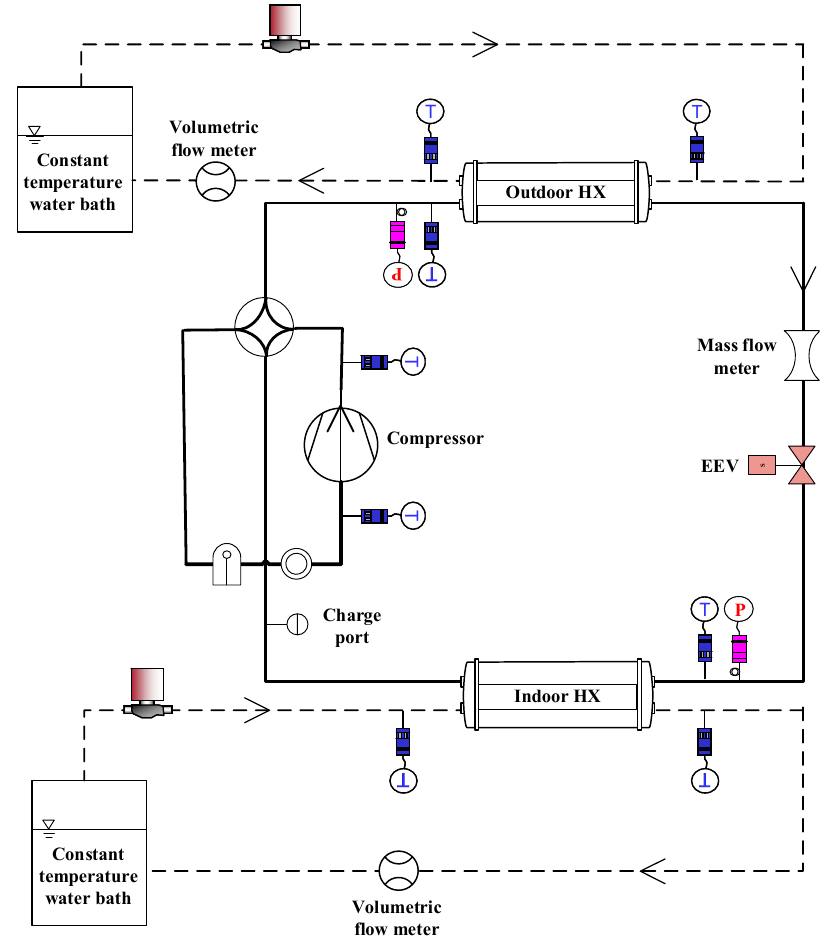
Figure 1. Schematic of heat pump Figure 1 . Schematic of heat pump unit.